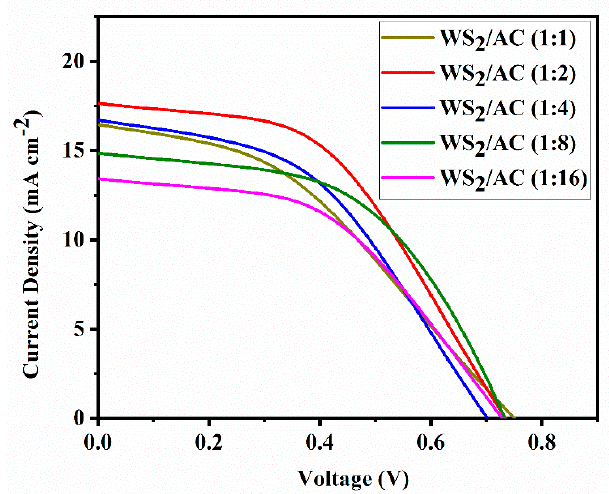
Figure 3. Current-voltage characteristics of the DSSCs assembled with different ratios of WS 2 /AC counter electrodes measuring under AM 1.5 solar simulator with 100 mW cm -2 illumination.